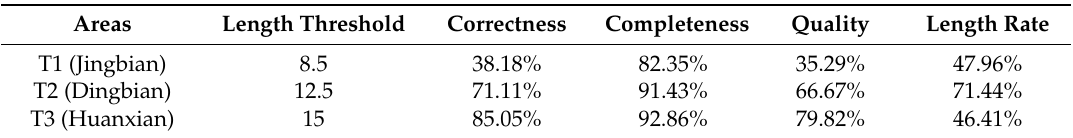
Table 3. Parameters and accuracy indices in the three